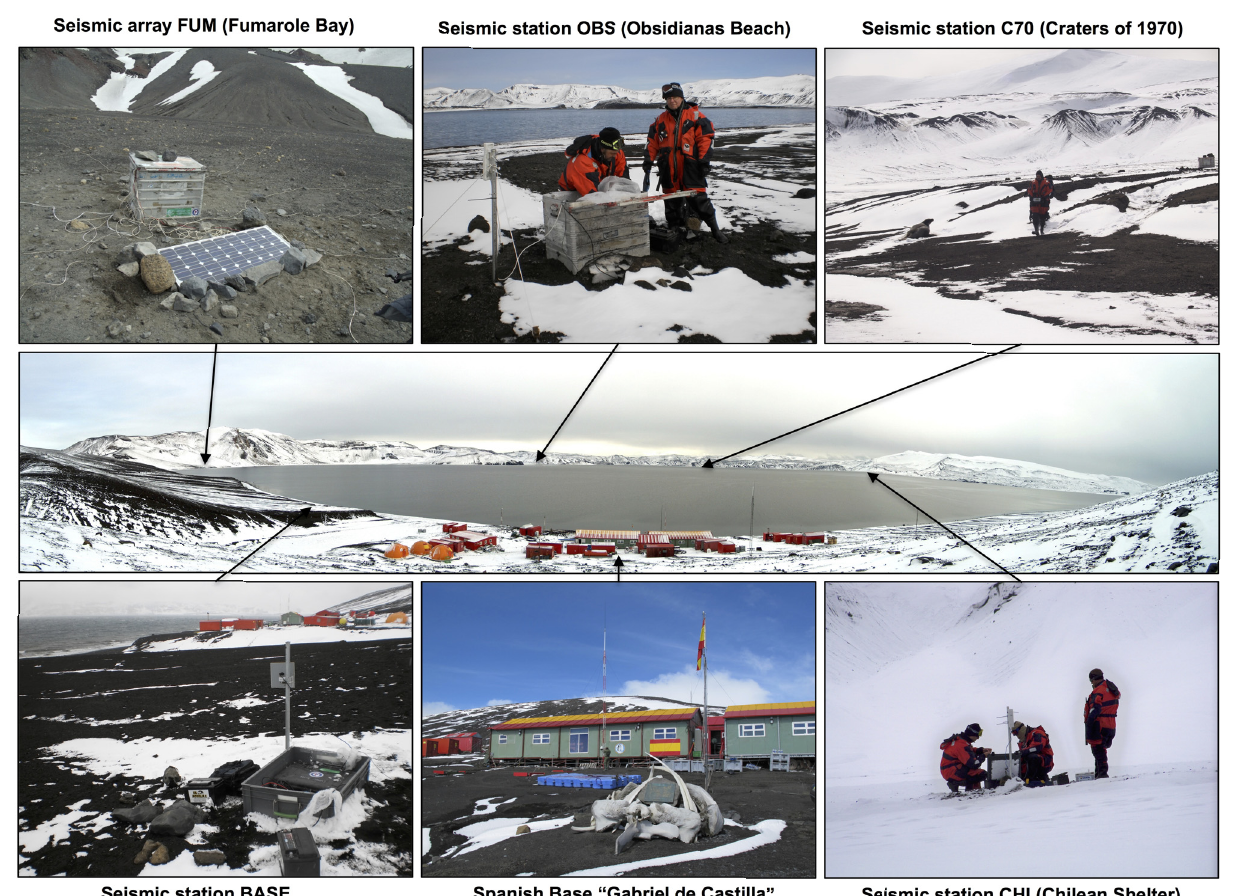
Figure 6. View of Port Foster with photos of the network and array